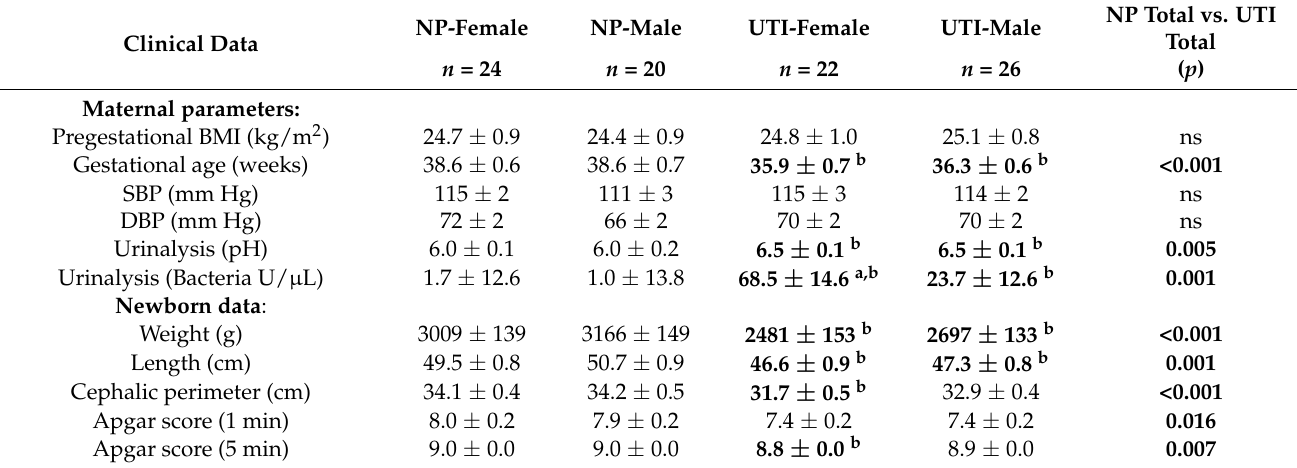
Table 1. Clinical data of mothers and